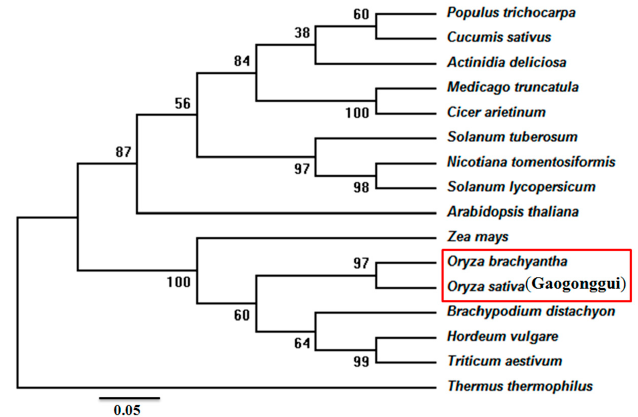
Figure 2. Phylogenetic analysis of the IMPase in rice cultivation in Gaogonggui and other plant species. The statistical reliability of individual nodes of the tree is assessed by bootstrap analyses with 1000 replications, and the bar represents the branch length equivalent to 0.05 amino acid changes per residue.